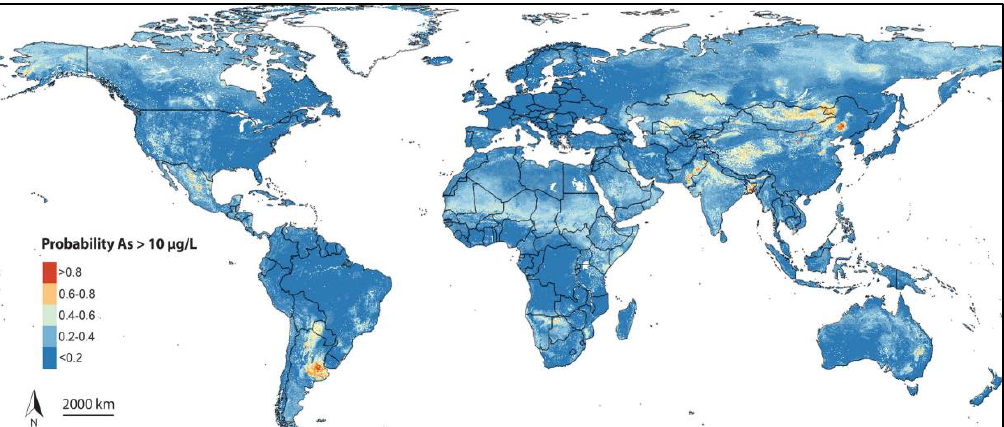
Figure 1. Modeled probability of arsenic concentration in groundwater exceeding 10 μg/L for the entire globe [8].